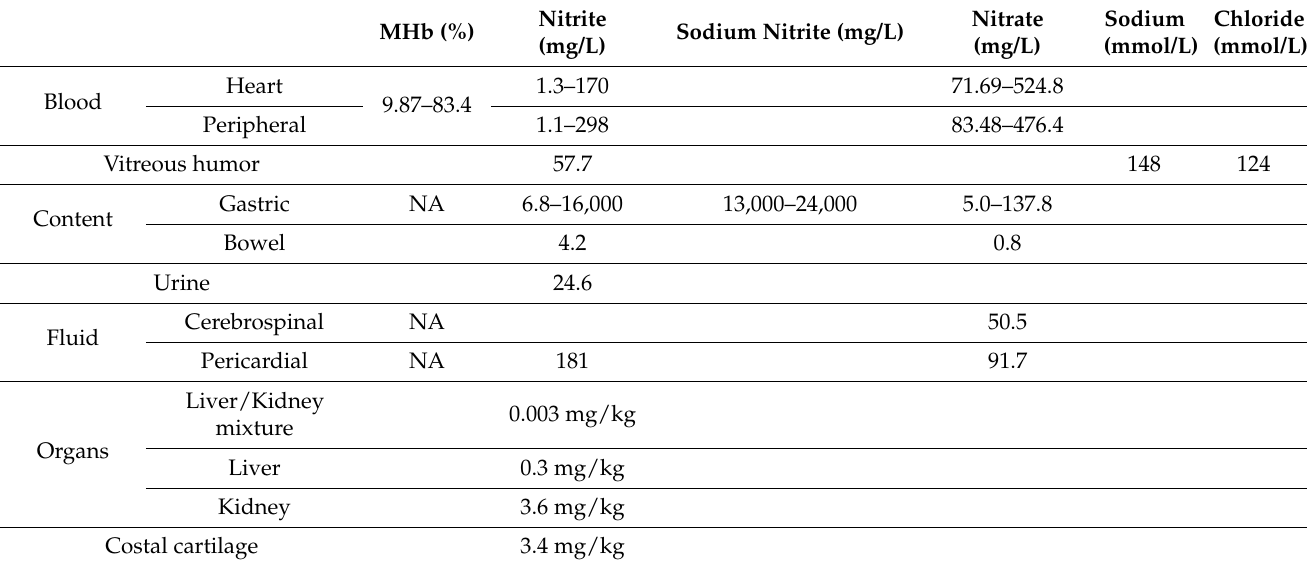
Table 3. Summary of the post-mortem toxicology